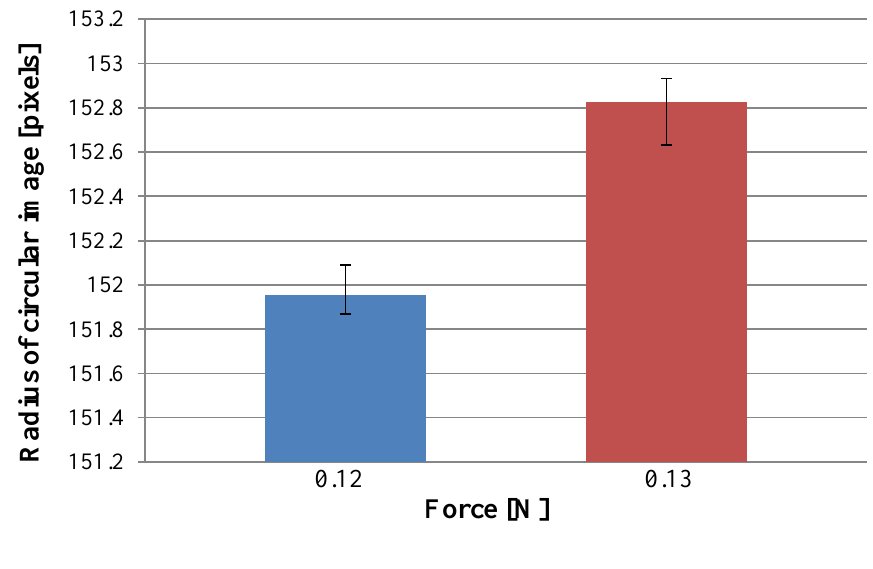
Figure 12. Radius of circular image of pin for 0.12 N and 0.13 N measured five times. Error bars show maximum